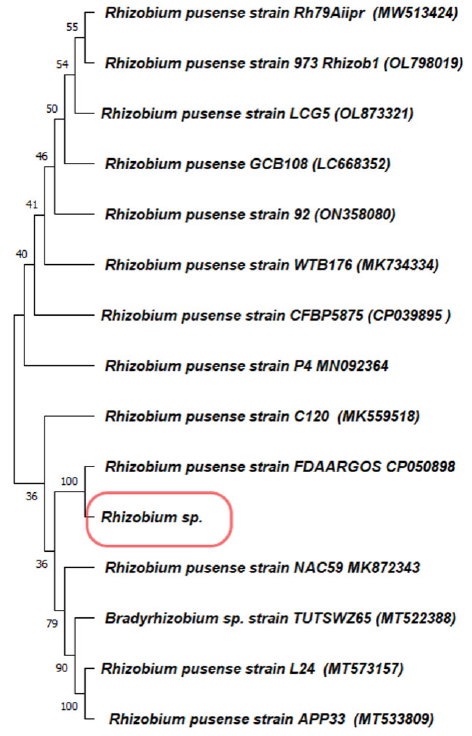
Microorganisms 2022 , 10 , x FOR PEER REVIEW Figure 1. Phylogenetic tree of the bacterial isolate from the root nodules. Figure 1. Phylogenetic tree of the bacterial isolate from the root nodules. The red ‐ colored suspended material was used for characterization using several methods, including UV–visible spectrophotometry, FTIR spectrophotometry, DLS, SEM, and TEM. The scanning of the red colloidal sample of the SeNPs using a UV–Visible spec ‐ trophotometer in the range 200–800 nm showed a sharp spectrum at 269 nm due to the Surface Plasmon Resonance mechanism [10] (Figure 2a). In Figure 2b, the FTIR spectrum gives away important functional groups responsible for the biotransformation of selenite into SeNPs. The intense broad peak at 3284 cm − 1 belongs to the –OH stretch of the hydroxyl group, whereas the small outgrowths at 2959 and 2927 cm − 1 are for the –C–H stretch of the methyl and methylene groups, respectively. The peak at 1658 cm − 1 shows alkenyl C=C stretching. The aromatic nitro compounds can be detected because of the peak at 1536 cm − 1 . Peaks at 1451 cm − 1 are attributed to carbonate ions, and at 1402 cm − 1 , to –OH bending because of the phenol or tertiary alcohol. The peak values 1233 cm − 1 and 929 cm − 1 refer to the P–O–P stretching of aromatic phosphates, while other peaks such as 1059 represent phosphate ions. The peak at 771 cm − 1 represents skeletal C ‐ C vibrations in methylene, and the one at 699 cm − 1 represents C–H bending of the aromatic group. Therefore, we can say that these complex functional groups contribute to the synthesis and stabilization of the biogenic SeNPs [30,31].